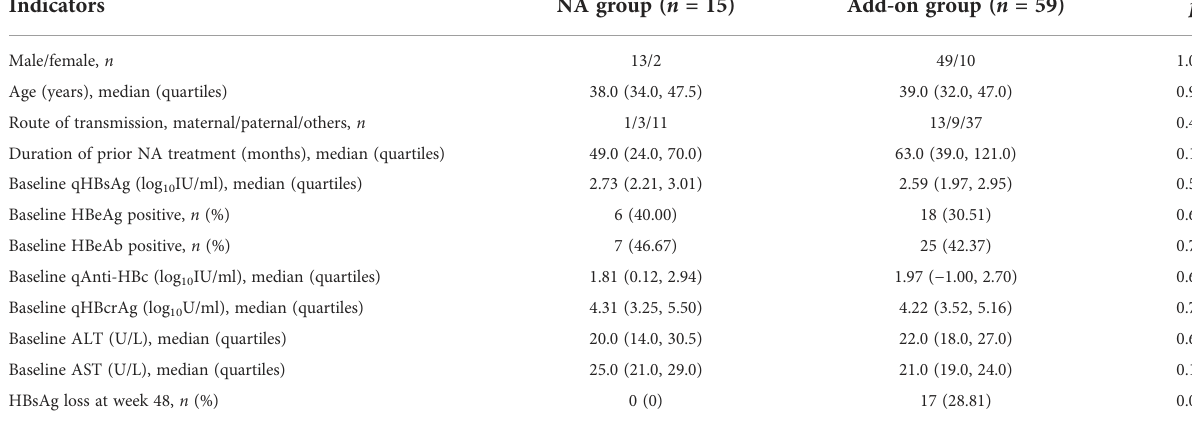
TABLE 1 Characteristics of the enrolled patients.